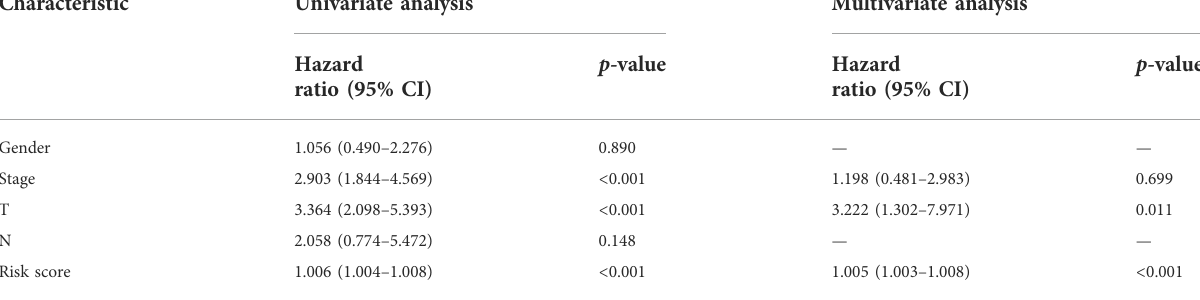
TABLE 2 Univariate and multivariate regression of CR signature and other clinical features in test cohort. Characteristic